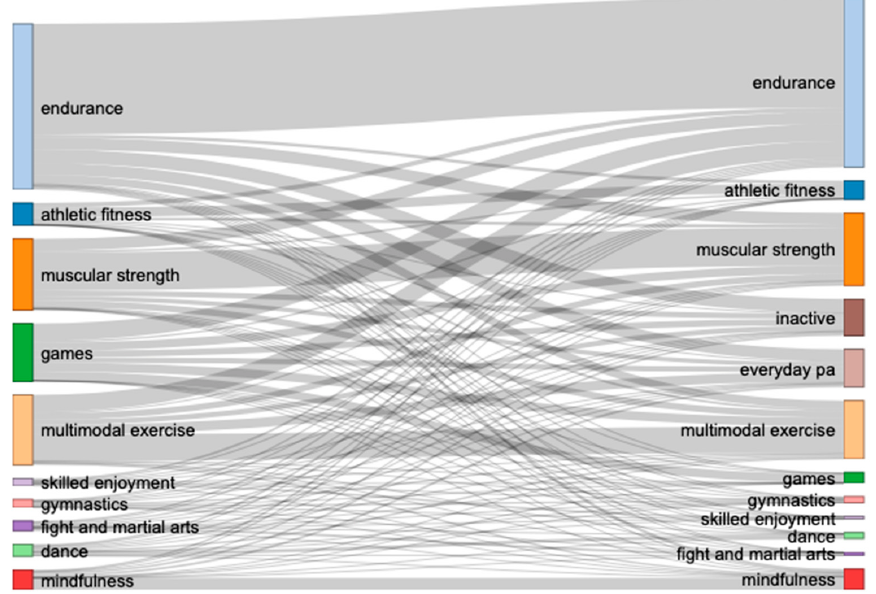
Figure 3. Changes in the specific category among participants that were categorized in the broad category of exercise/sport and mindfulness before COVID ‐ 19. Note that ‘before COVID ‐ 19’ is depicted on the left and ‘during the initial COVID ‐ 19 lockdown’ on the right side.